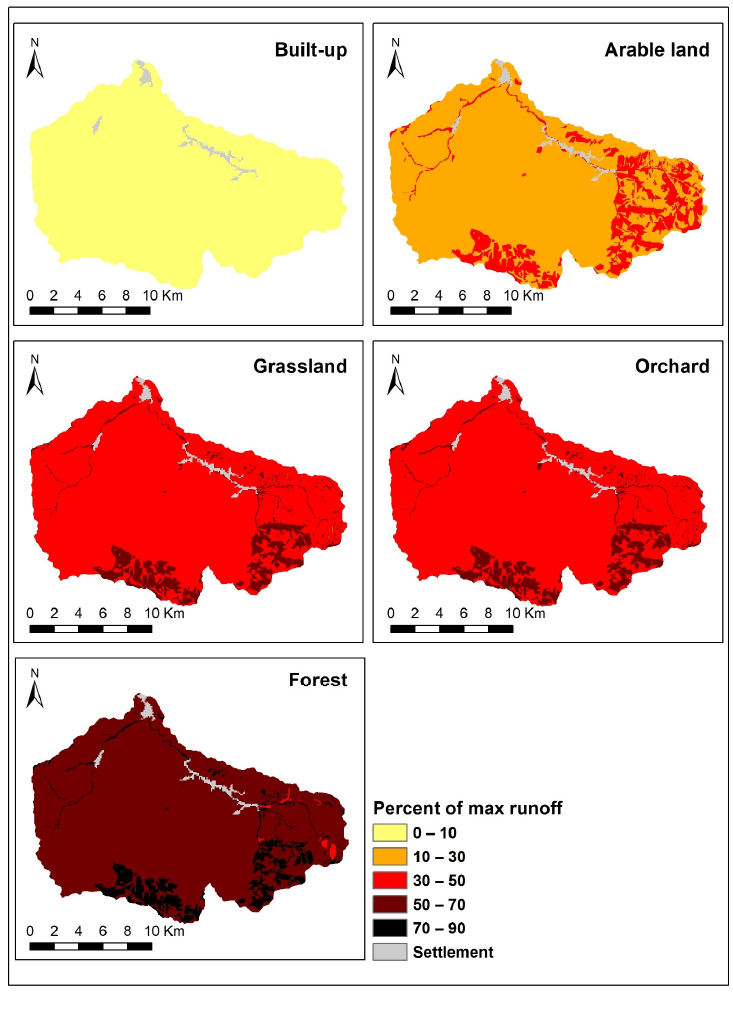
Figure 4. Proportion of maximum runoff retained (from 80 mm precipitation) if the whole area was covered by single land use. Water 2021 , 13 , x FOR PEER REVIEW